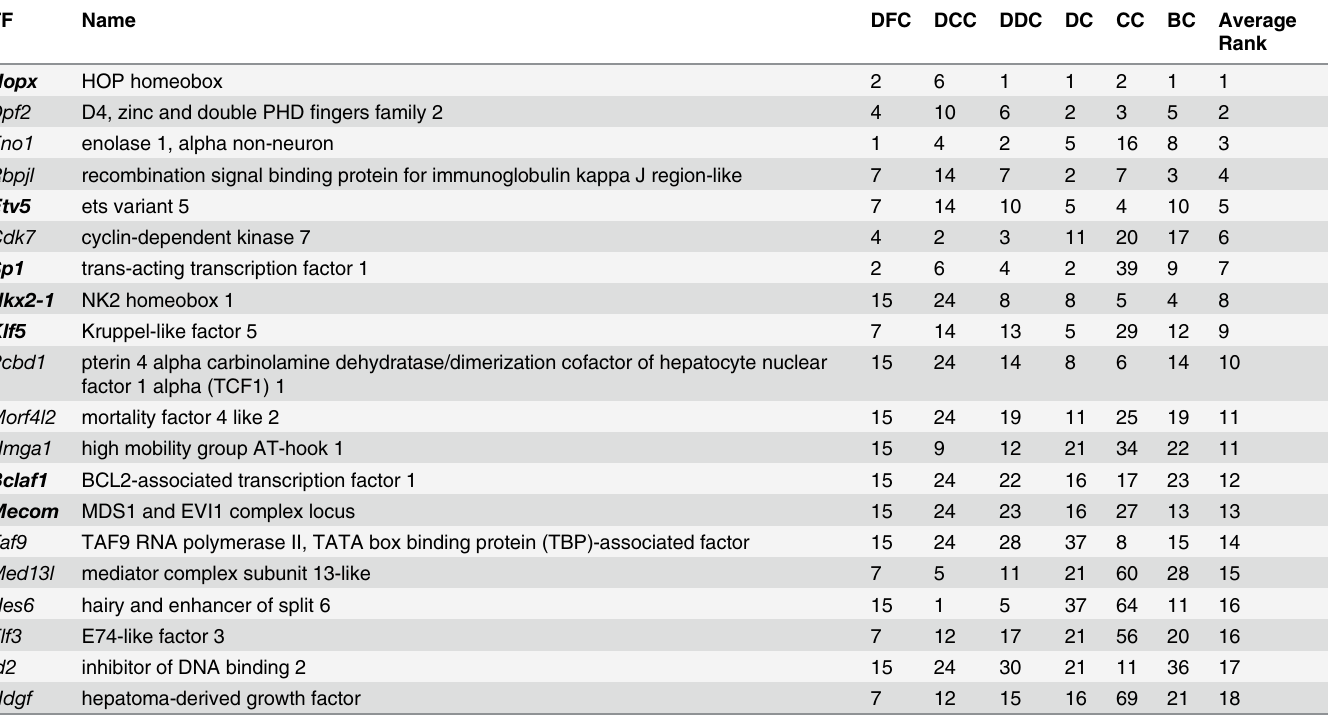
Table 1. Top 20 Predicted Key Transcription Factors for Lung Epithelial Cells at